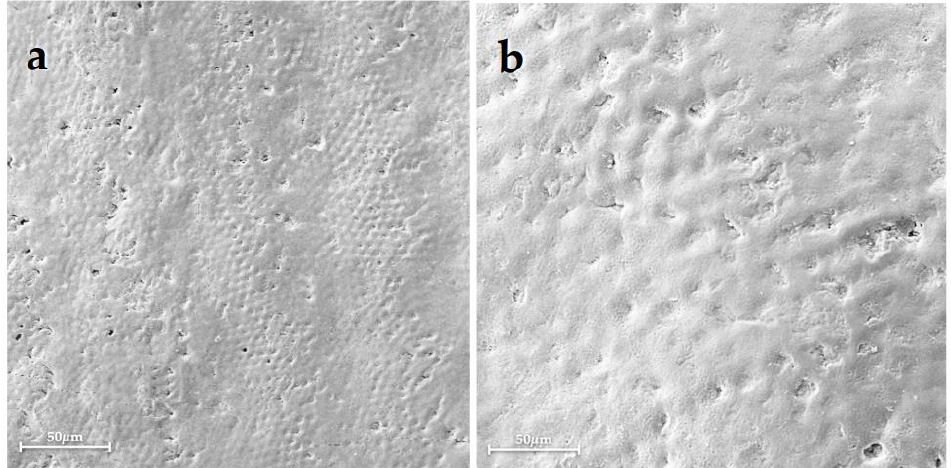
Figure 1. Scanning electron micrographs of the Group 1 displayed ( a ) at 500 × magnification, showing the typical morphology of sound enamel with emphasized perikymatas; and ( b ) at 1000 × magnification, showing slight erosion of the enamel surface.